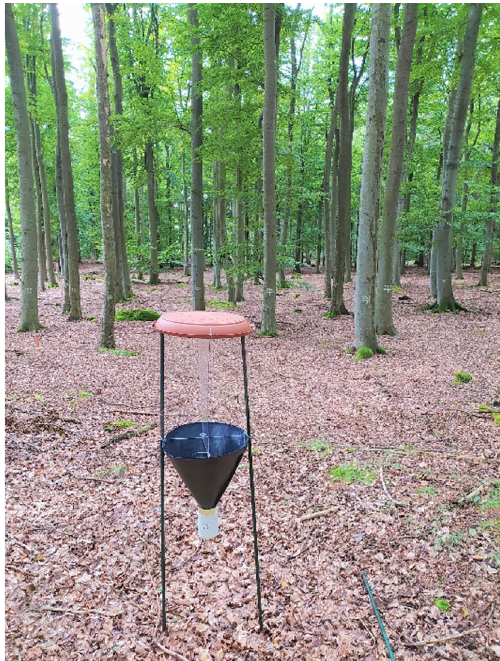
Figure 3. Passive interception flight traps located in optimum stage of beech